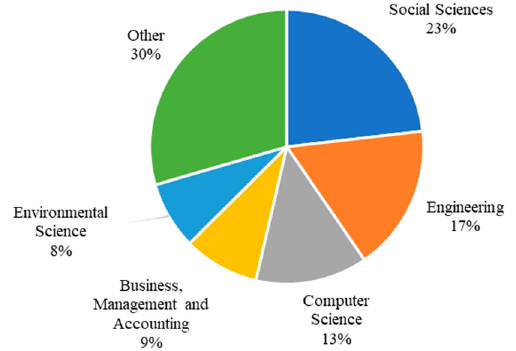
Figure 6. Number of papers related to city logistics and tourism by subject area. Source: Own elaboration based on data from the Scopus database.